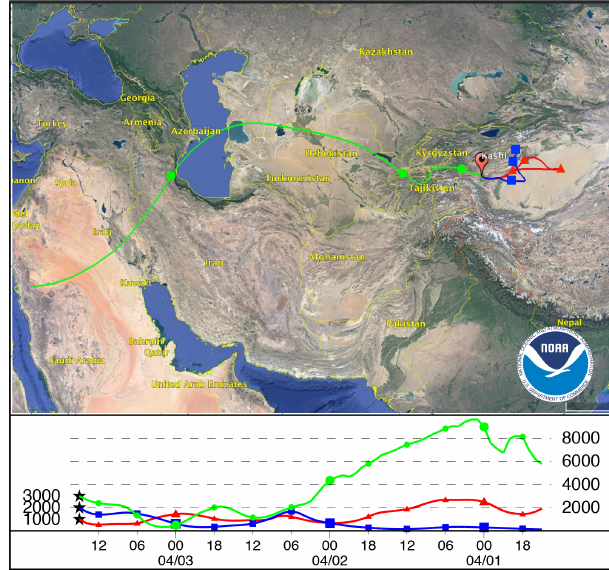
Figure 13. Case 4: the 72h back trajectories ending at 15:00UTC, 3 April 2019, for air masses at 1000, 2000 and 3000m. © Google Maps